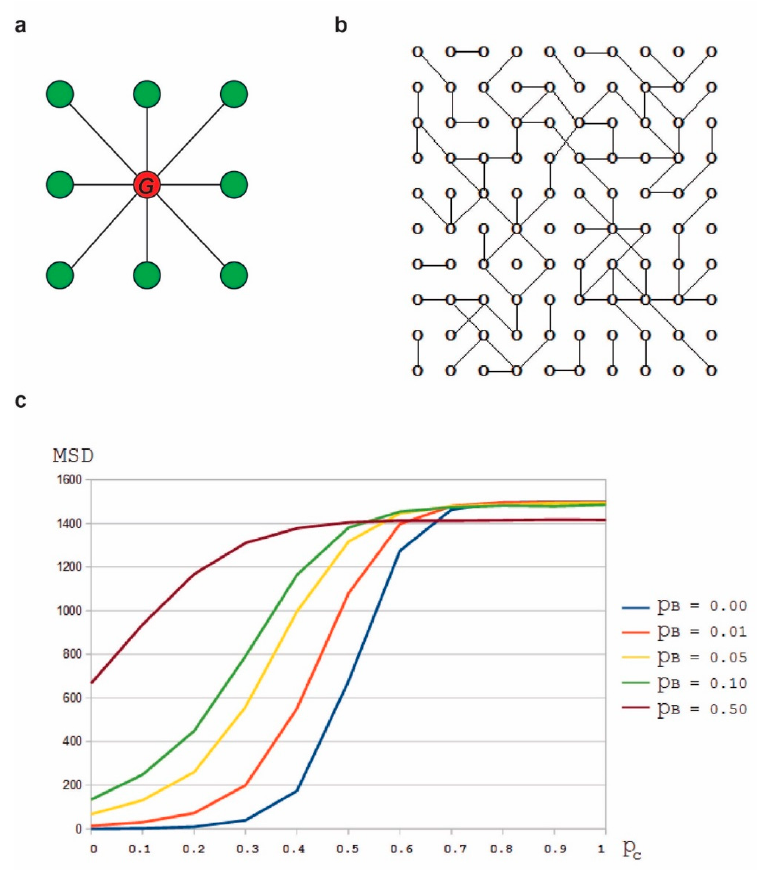
Figure 4. ( a ) Neighborhood of the red node consists of the set of green nodes. We connect the red node with each of the green nodes in its neighborhood with a probability p c . We do this by generating a random number between 0 and 1 for each of the green nodes and check if this random number is less than p c . If this is the case, then the red node and the green node are connected, otherwise they are not connected. ( b ) An example of a small cellular graph with p c = 0.35. ( c ) MSD ( p c , p B ) versus p c diagram, for di ff erent values of p B (the probability of a particle to reach a neighbor node by Brownian motion. For each value of p c in the set {0, 0.1, 0.2, . . . 0.9, 1} we generate 100 random instances of